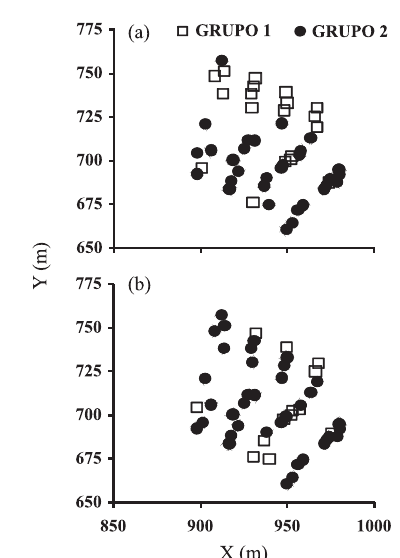
Figura 5. Distribuição dos pontos amostrais segundo a análise de agrupamento para as variáveis reais (a) e os cinco componentes principais